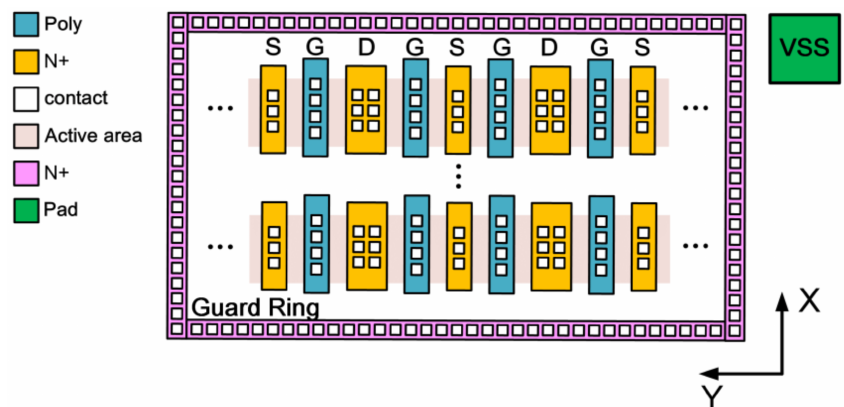
Figure 3. Layout top view for multi-finger NMOS in ESD clamp (simplified layout, N = 8).